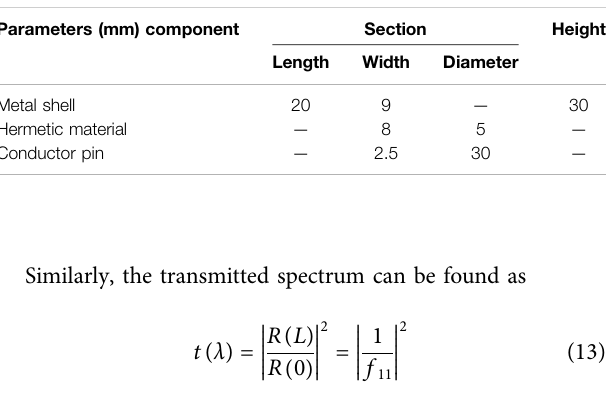
Frontiers in Energy Research |